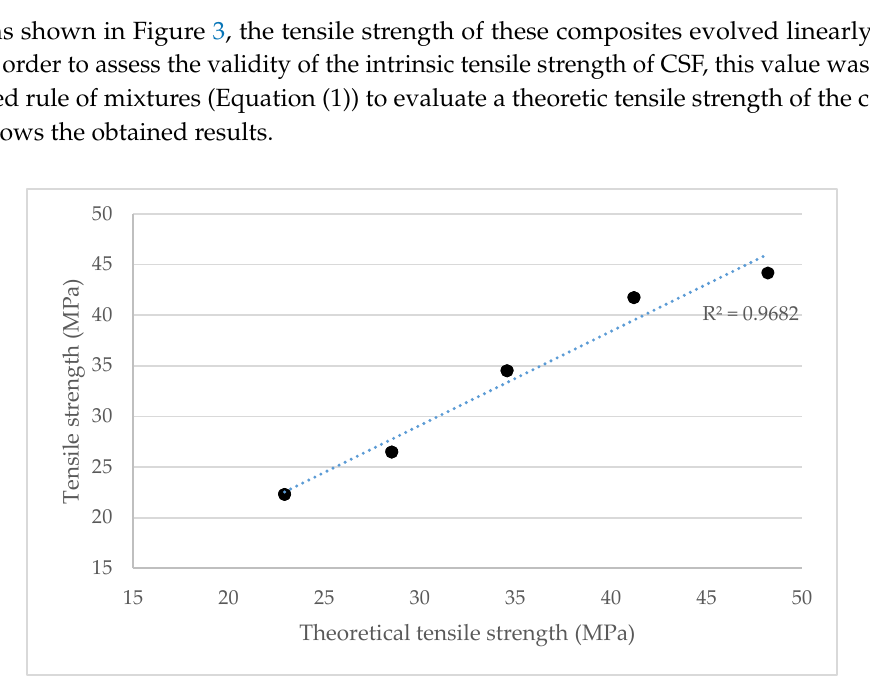
reinforced BioPE composites coupled with 6 wt. % of MAPE.